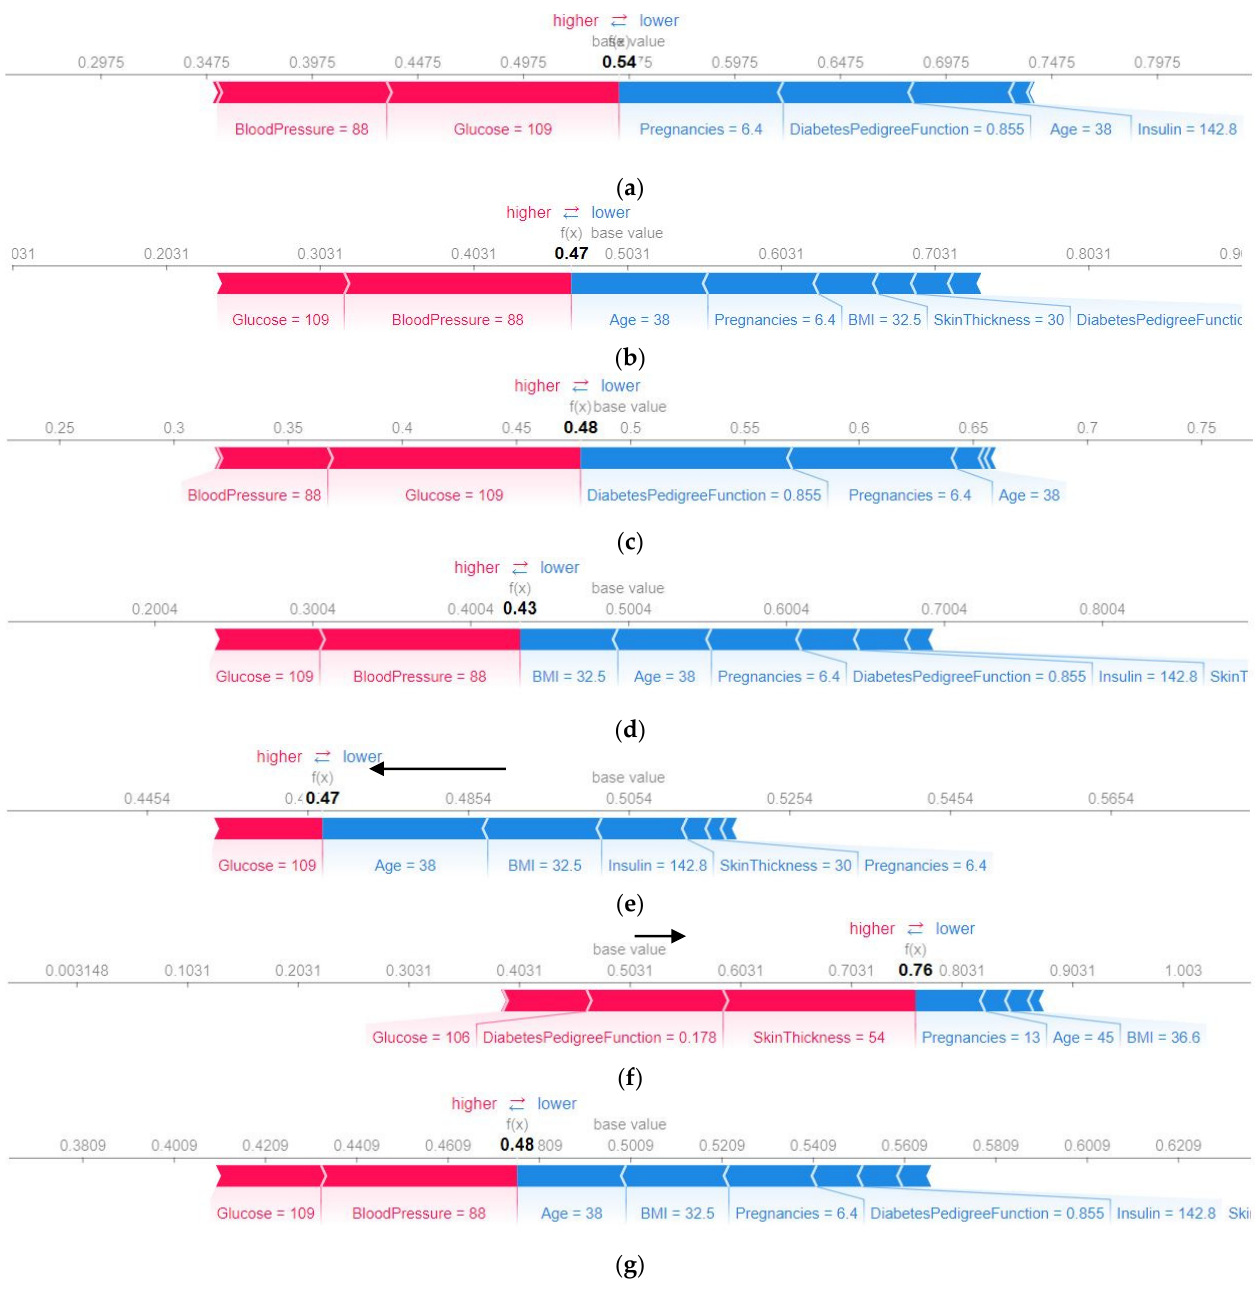
Figure 7. SHAP force plot of ( a ) ANN, ( b ) SVM, ( c ) LR, ( d ) RF, ( e ) ADA, ( f ) XGB, and ( g ) Voting classifier using the five-fold.